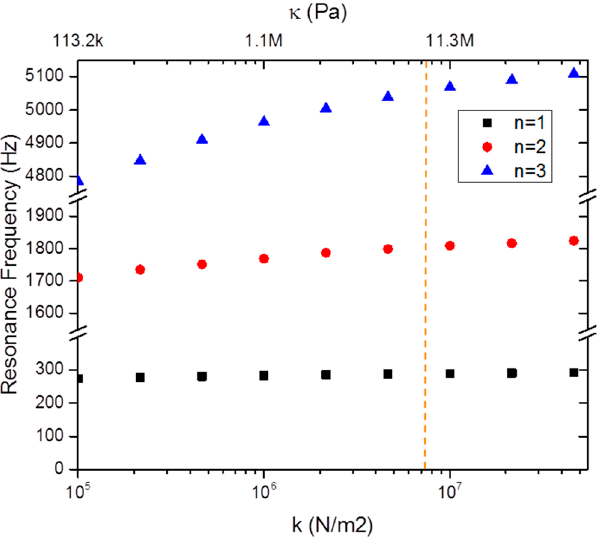
Figure 4. The resonance frequencies predicted for the sensors for various nanotube stiffness values ( κ ) or values of the stiffness-per-length constant in the elastic base model ( k ). The other properties of the modeled sensors are identical to Sensor 3 with L E = 4.37 mm. The dashed line represents the measured nanotube stiffness of Sensor 3.